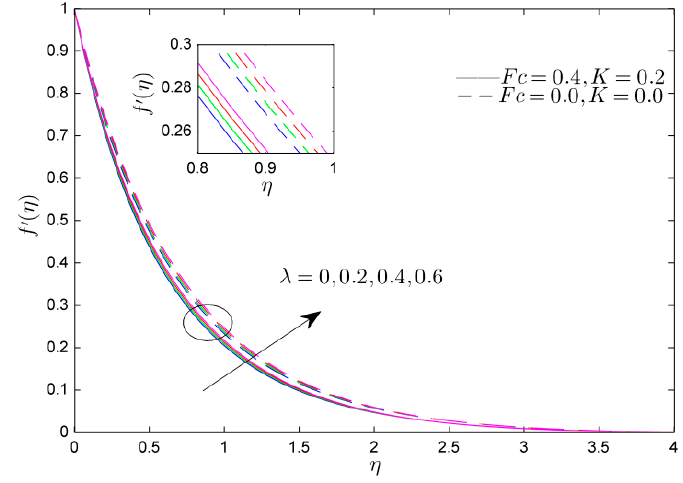
Figure 4. Effect of Richardson number (𝜆) on 𝑓 (cid:4593) (𝜂) .